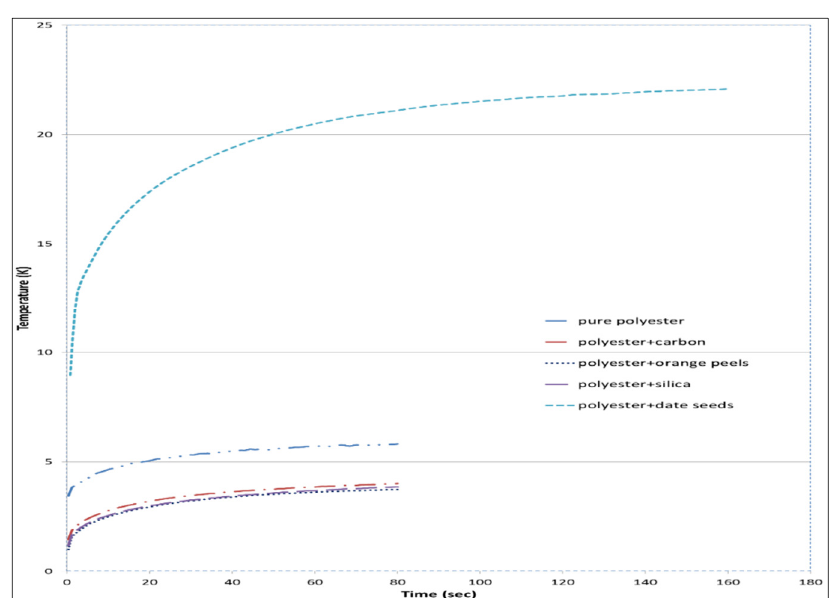
Fig. 13. Variation of temperature with